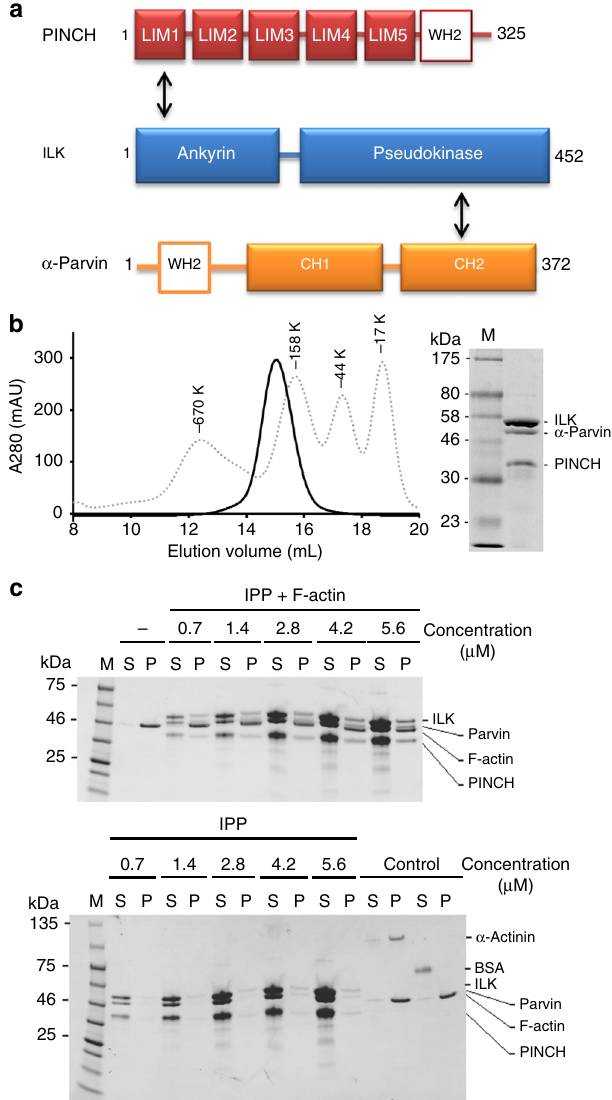
Fig. 1 IPP interaction with F-actin. a Schematic organization of IPP based on structural data. ILK binds to PINCH LIM1 via its ankyrin domain and α - Parvin CH2 via its pseudokinase domain, respectively. The Wiscott – Aldrich syndrome protein (WASP) homology domain (WH2) motifs are highlighted in PINCH and α -Parvin. b A representative gel fi ltration pro fi le of the puri fi ed IPP complex by Superose 6 10/300 GL size exclusion chromatography column (GE healthcare). The eluted peak is overlaid with an elution curve of standard molecular weight proteins (dot lines). c Co- sedimentation of IPP at dose-dependent amounts in the presence/absence of F-actin. The F-actin was incubated at 2.3 μ M constant concentration with increasing concentrations of each test sample in 5% glycerol containing protein buffer. Representative gels with Coomassie stain are shown. M marker proteins, S supernatant, P